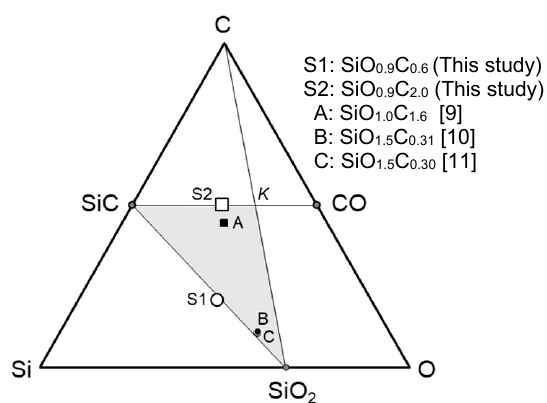
Figure 2. Chemical compositions of the polymer-derived amorphous SiOC reported in literature [9,10,11], and those of the S1 and S2 derived from SQs synthesized through the sol-gel route shown in Equation (4). For the synthesis of S1 and S2, silsesquioxane (SQ) derivatives which have intramolecular H 2 C = CH- groups and Si-H groups labeled as VH-SQ and St-H-SQ were designed respectively, and synthesized through the conventional sol-gel route (Equation (4)). The thermal decomposition of organic substituents, as well as the thermally induced in situ cross-linking during pyrolysis of the SQ derivatives, were characterized. Then, phase separation and crystallization of the SQ-derived